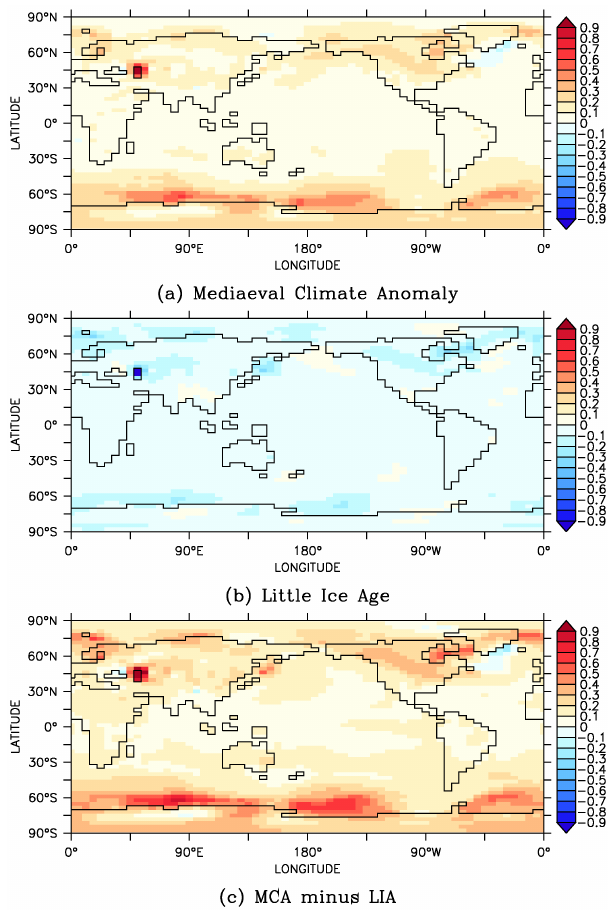
Fig. 15. The simulated changes in surface air temperature (K) dur- ing the Mediaeval Climate Anomaly (MCA; 1001–1250CE) and the Little Ice Age (LIA; 1400–1700CE), according to experiment LAST1000: (a) the MCA minus the 1001–1850CE mean, (b) the LIA minus the 1001–1850CE mean, and (c) the MCA minus the